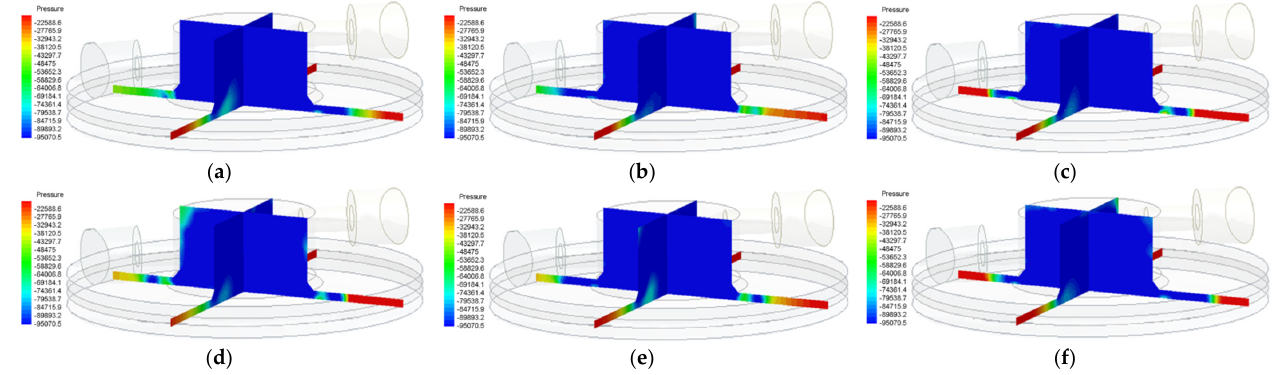
Figure 24. When inlet pressure = 15 MPa, gap = 1.5 mm, the variation of pressure of suction cup- θ 20 with time in vertical axial cross planes at: ( a ) 5 ms, ( b ) 9.4 ms, ( c ) 13.8 ms, ( d ) 18.2 ms, ( e ) 22.6 ms, and ( f ) 27 ms.